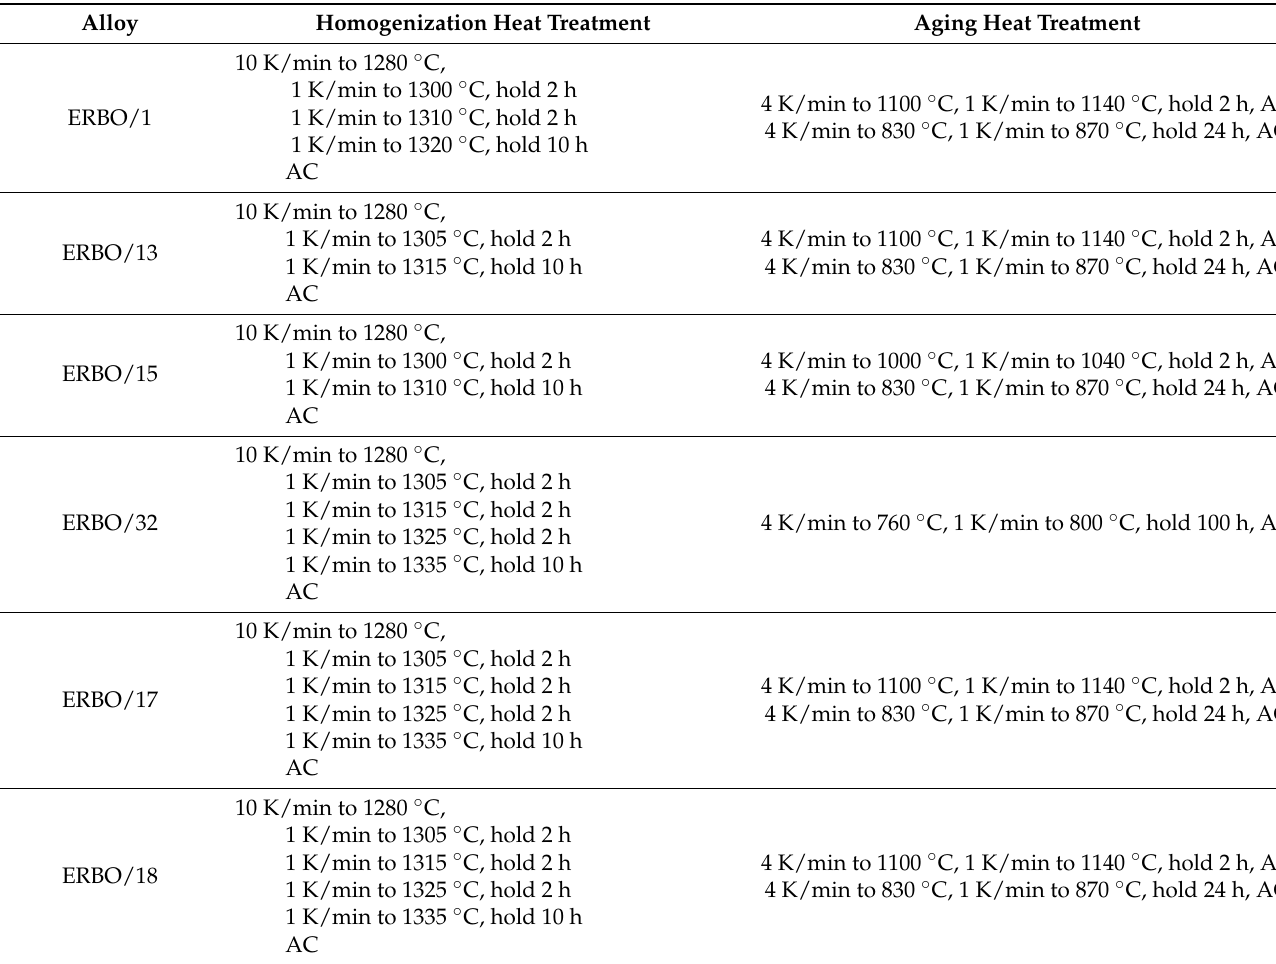
Table 2. Overview of heat-treatment procedure for all single crystalline alloys. AC is short for air-cooling at room